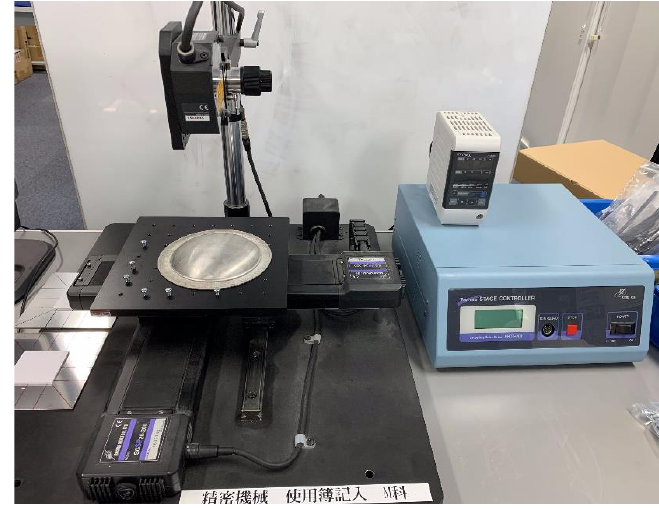
Figure 8. Three-dimensional shape measuring device.